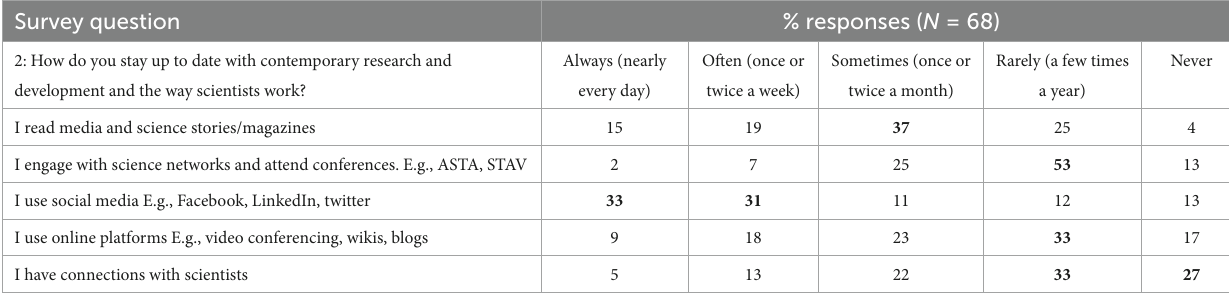
TABLE 2 Responses to survey question 2 (Modal responses bolded).